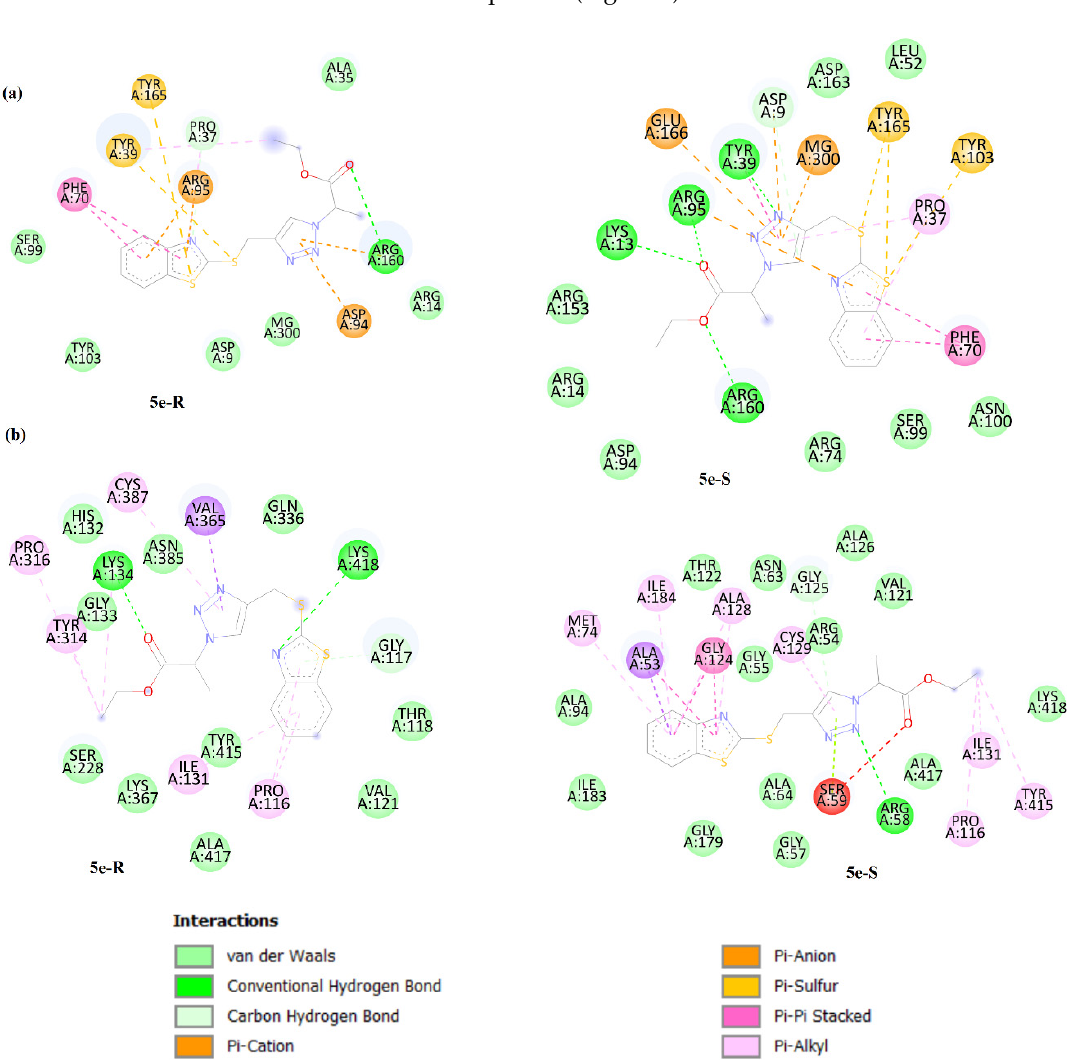
Figure 7. Two-dimensional illustrations of the interaction types between 5e-R and 5e-S and protein targets, 1G3U ( a ) and 4P8N ( b ).